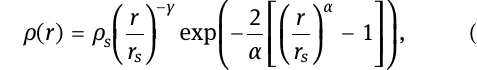
Eq. ( 17 ) shows that the inner cusp is still − r 1 . If M h is small enough (